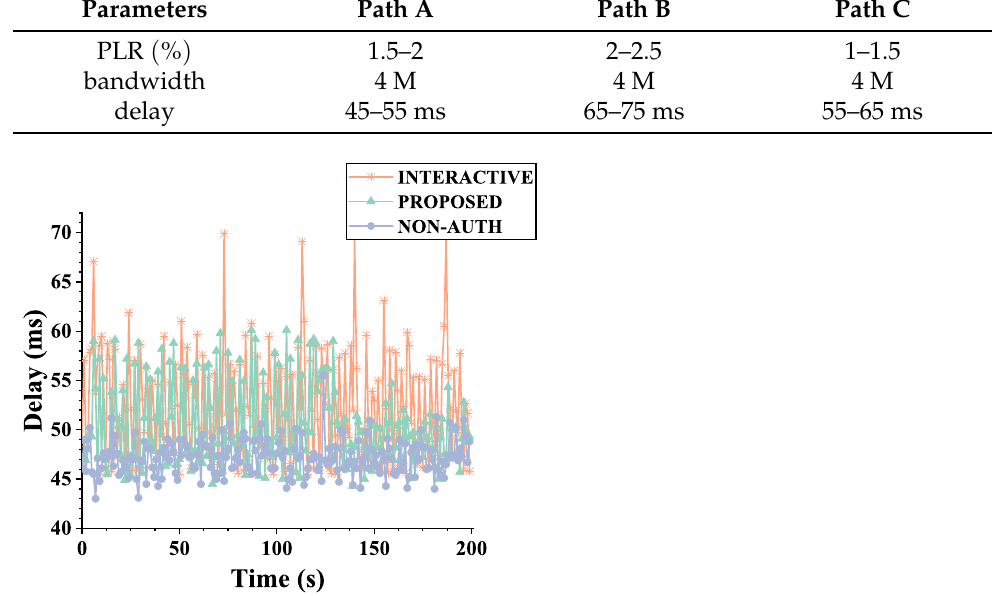
Figure 13. Data transmission delay under multipath settings; comparison of the proposed scheme, interactive scheme, and no security